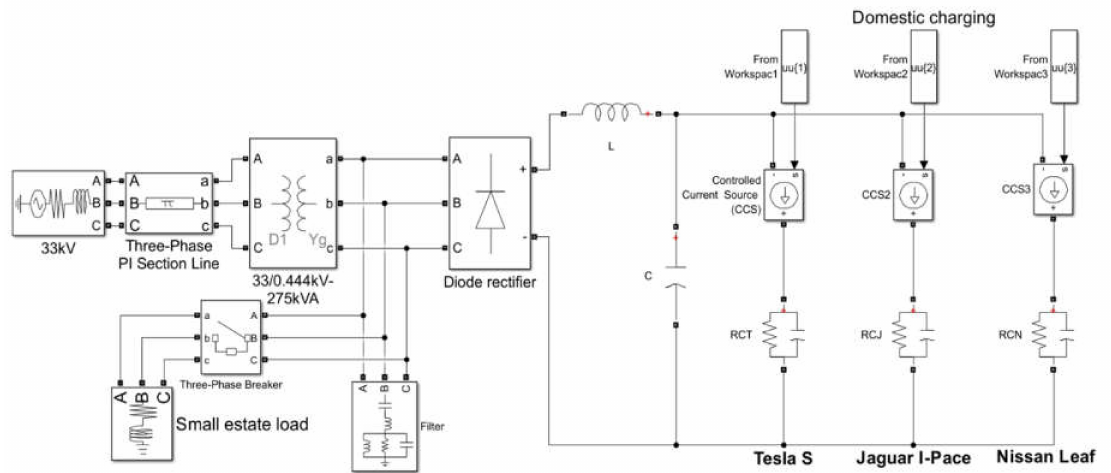
Figure 11. Grid system with small estate